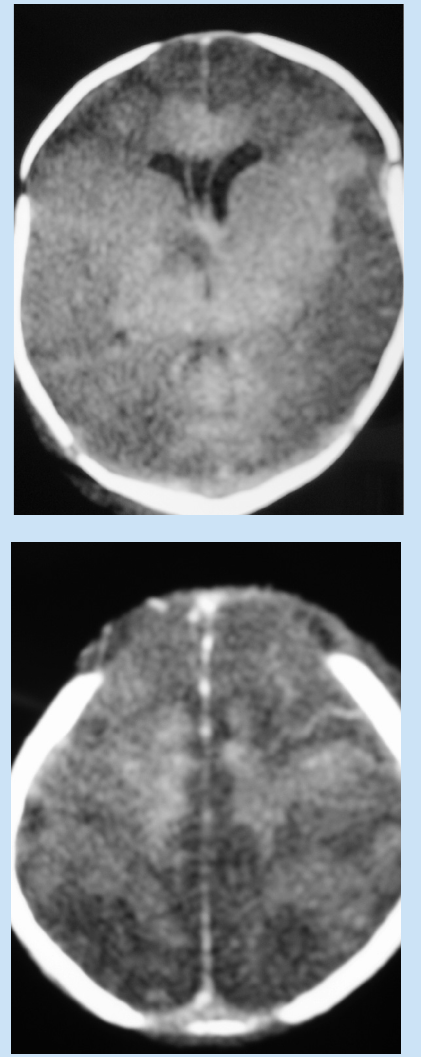
Fig. 2a and b. Reversal sign. There is central hyperdensity compared with the peripheral cortex, involving the thalami and central white matter, as well as in the infratentorial structures.